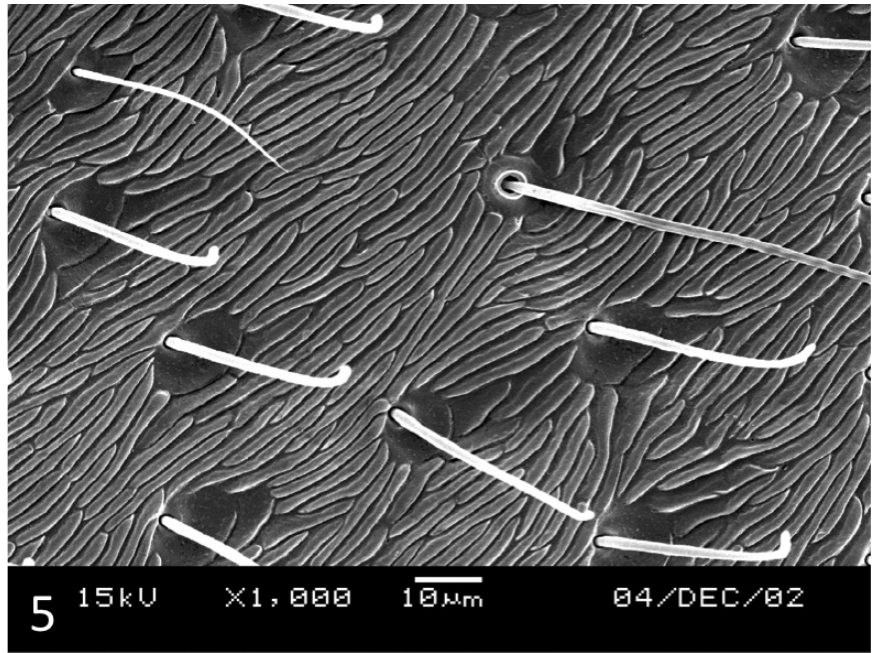
Figure 5. Leiodytes kualalipis sp. n.: female paratype, SEM of microreticulation on